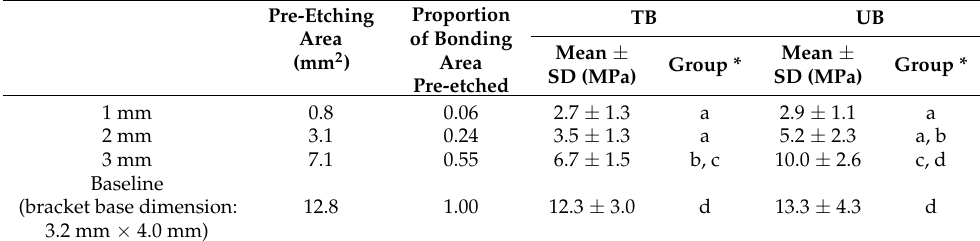
Table 1. Shear bond strength by pre-etched area.